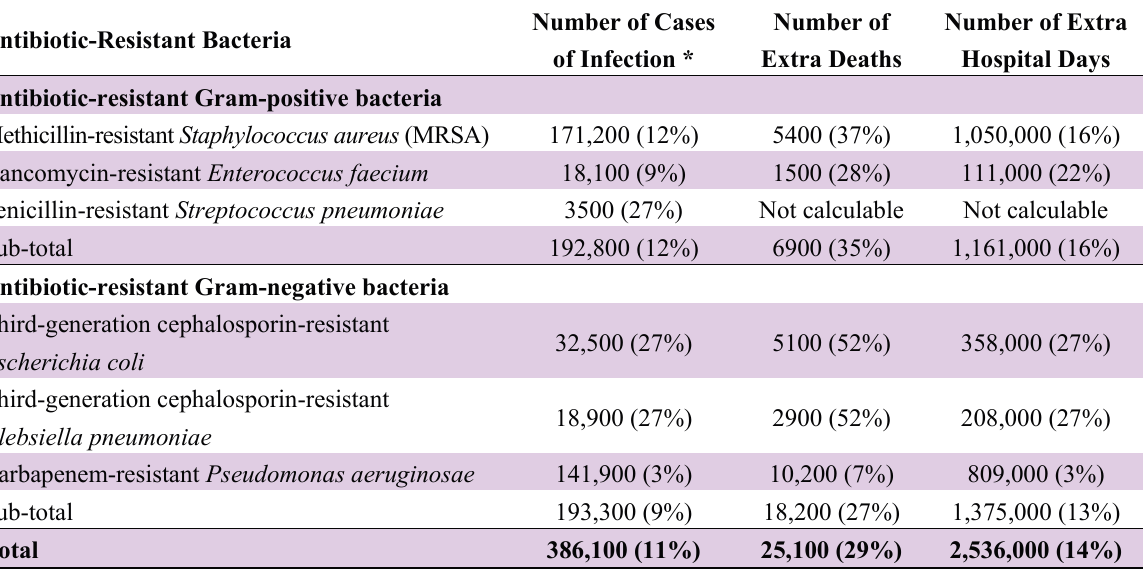
Table 1. Estimated 2007 morbidity and mortality due to selected antibiotic-resistance bacteria in EU Member States, Iceland and Norway (reproduced from [3] with